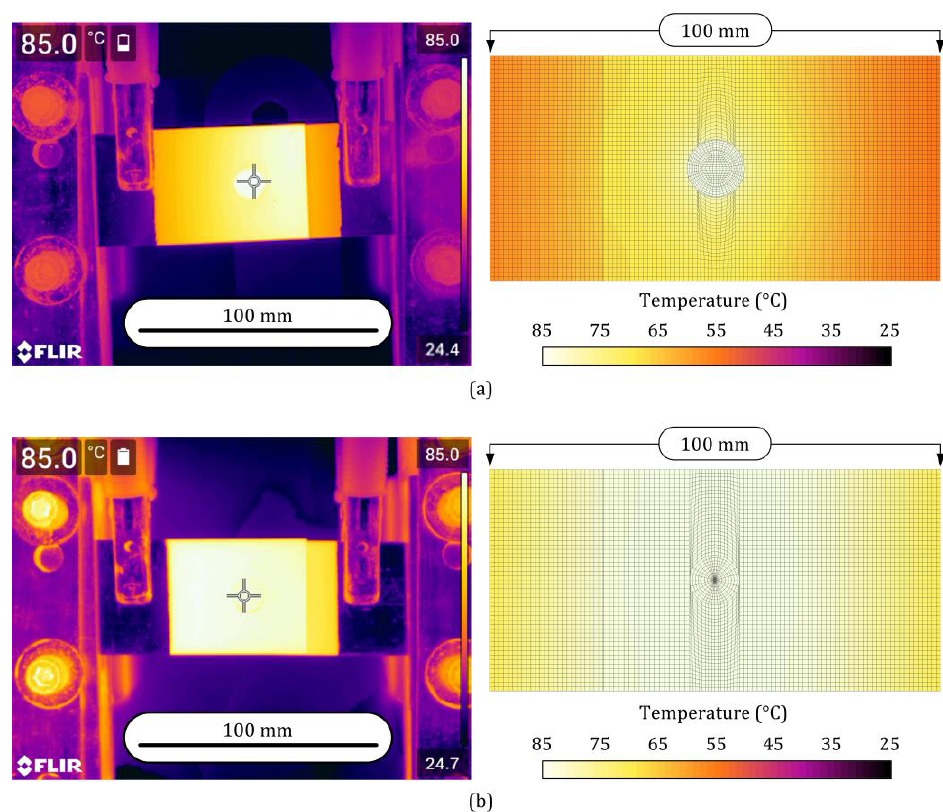
Figure 10. Experimental and finite element predicted distribution of temperature for an instant cor- responding to a temperature of 85 °C at the center of the ( a ) injection lap riveted and ( b ) bolted joints.